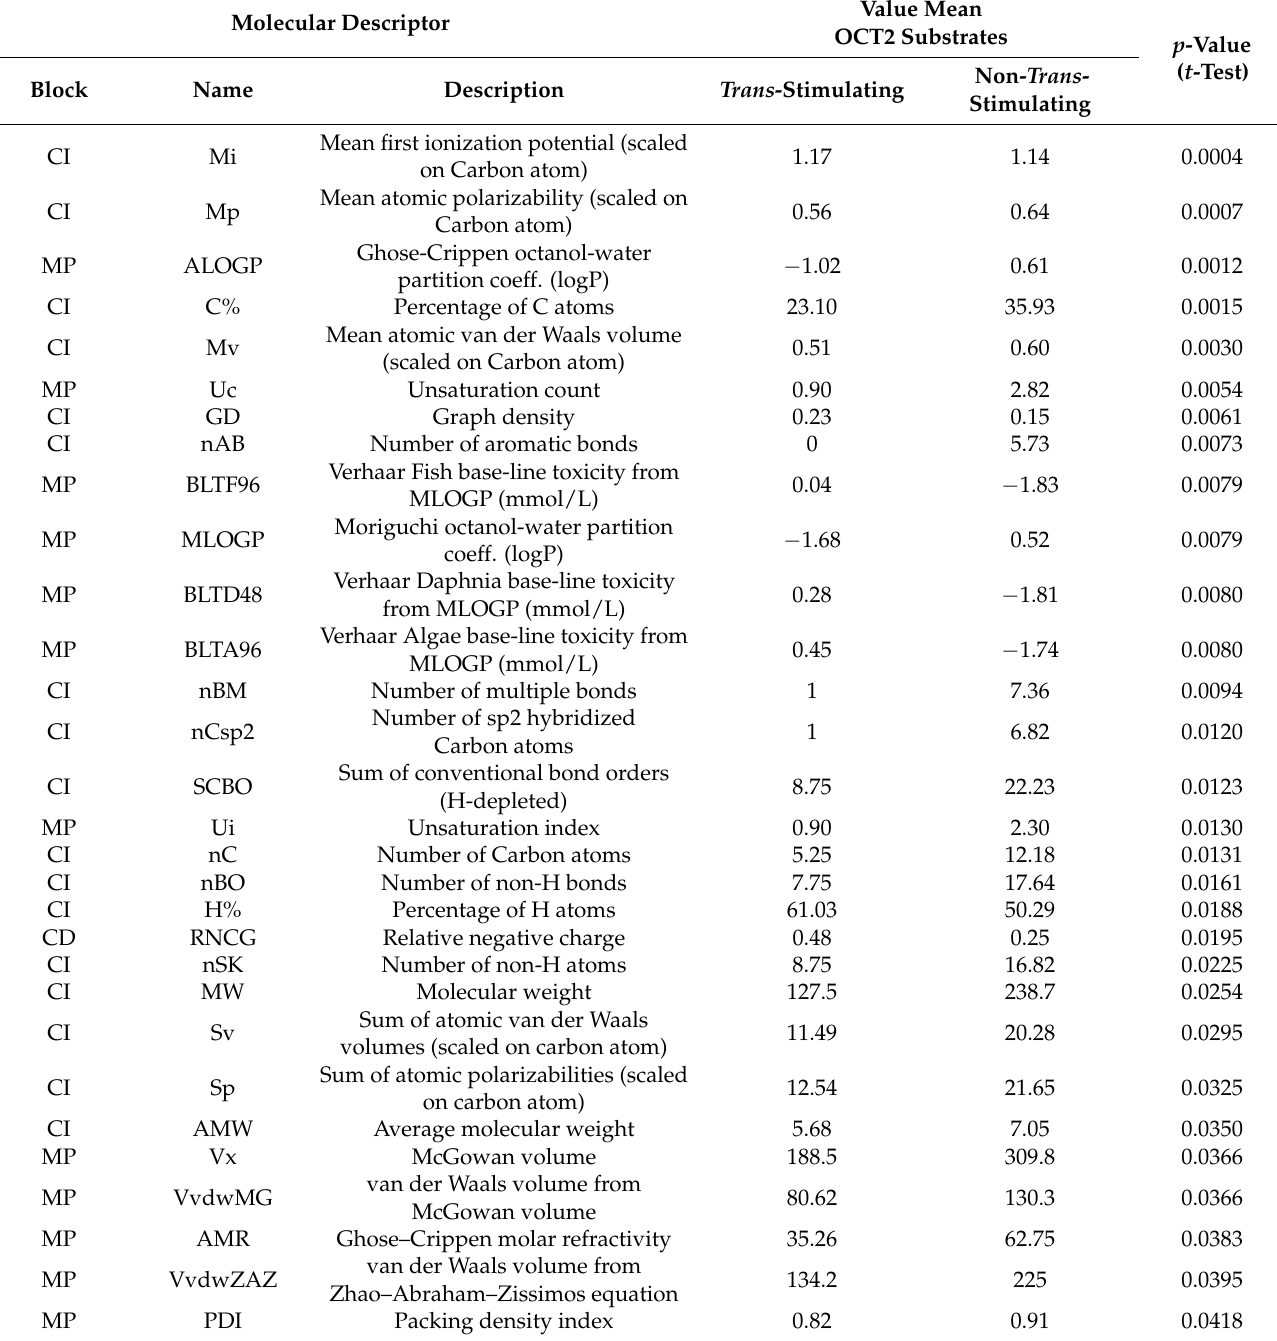
Table 2. Molecular descriptors significantly discriminating OCT2 substrates according to their trans -stimulation properties towards OCT2-mediated DiASP uptake. CI, constitutional indices; MP, molecular properties; CD, charge